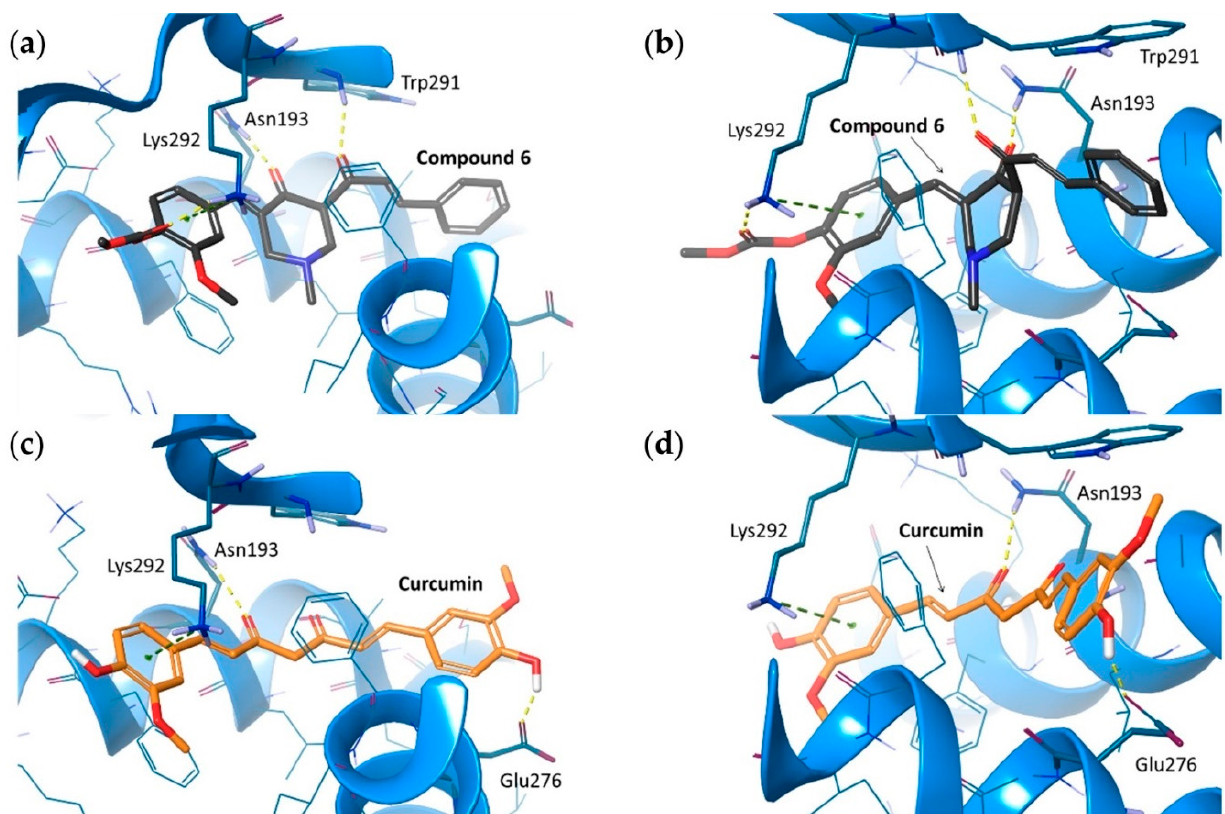
Figure 7. Molecular interactions formed between PTP1B (code 1T48) amino acid residues and its docked allosteric inhibitors: Compound 6 ( a , b ) and curcumin ( c , d ). Amino acid residues within 5 Å displayed as thin, blue sticks; amino acid residues engaged in ligand binding throughout H-bonds (dotted yellow lines) and π -cation interaction (dotted green lines) displayed as bold, blue sticks.